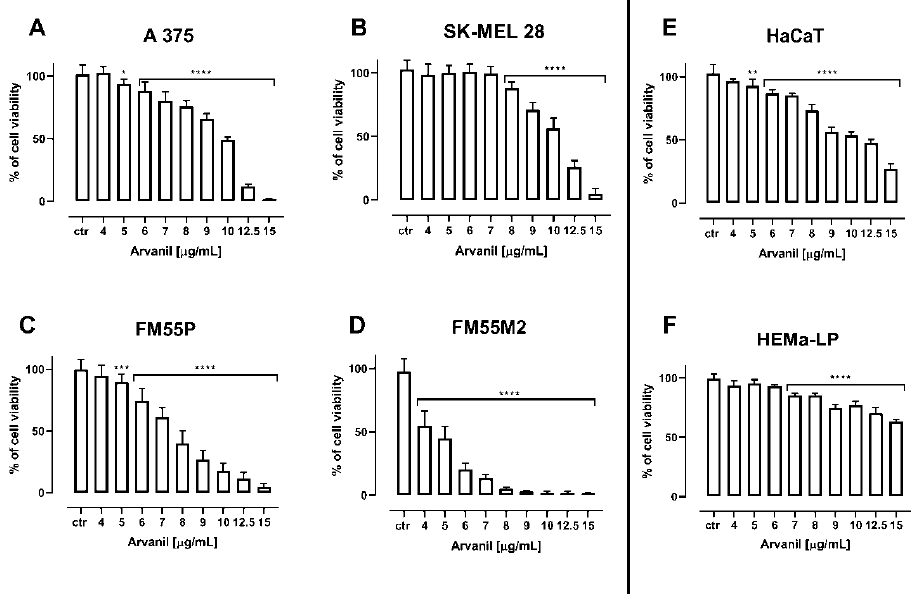
Figure 2. The impact of arvanil on the viability of malignant melanoma cell lines [A375 ( A ), SK–MEL 28 ( B ), FM55P ( C ) and FM55M2 ( D )], normal human keratinocytes [HaCaT] ( E ), and normal human melanocytes [HEMa–LP] ( F ), measured by means of MTT assay after 72 h. Columns represent mean ± SEM ( * p < 0.05, * * p < 0.01, *** p < 0.001, and **** p < 0.0001).